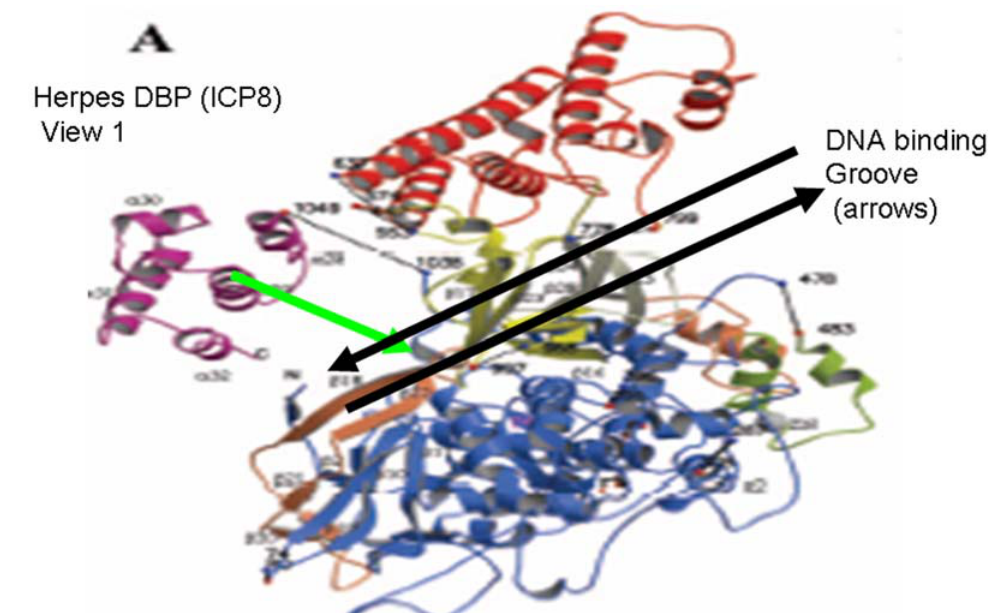
Figure 9. Putative magnesium ion binding regions of the DBP can be localized adjacent to the DNA binding groove of the ICP-8 protein structure. The partial crystal structure of herpes simplex DBP ICP-8 is shown with experimentally determined DNA binding groove shown, while experimentally determined structures of RAG proteins and other herpes DBP are not solved currently. A black double arrow illustrates the experimentally determined DNA binding groove of ICP-8, while a green arrow indicates the hypothetical position of a bound magnesium ion in ICP-8 as localized by conserved blocks of D and E residues shared with RAG-1 in regions of ICP-8 (Figure 8). This alignment shows that the predicted Mg binding site geometry of ICP-8 is in proximity to the bound DNA as in other structurally characterized DDE enzymes such as RISC. These structural similarities are consistent with and support descent of DBP and RISC proteins from a common precursor DDE recombinase.